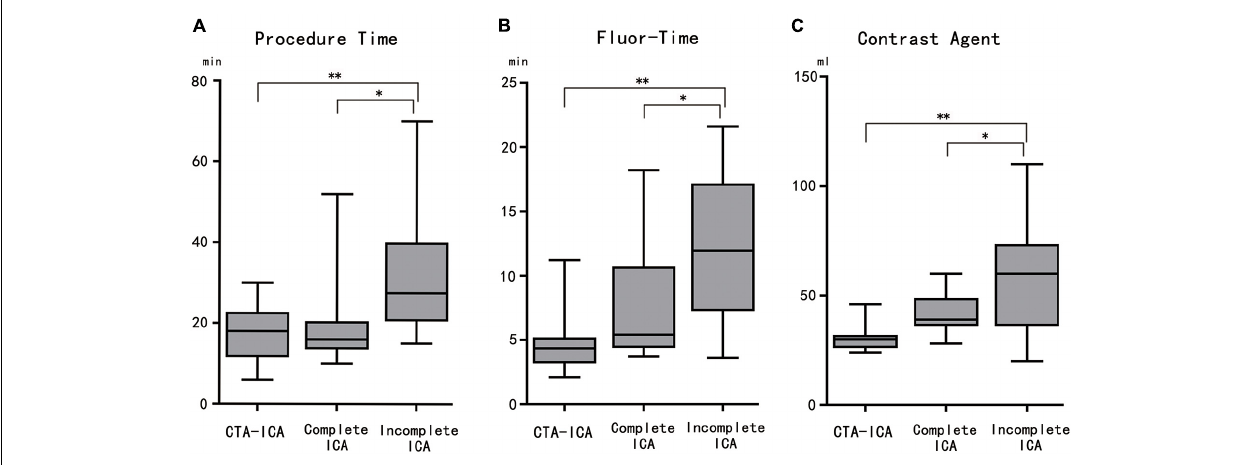
FIGURE 4 | The comparison among CTA–ICA and complete and incomplete direct ICA groups. The procedure time (A) , fluor-time (B) , and contrast agent consumption (C) of the incomplete direct ICA group are significantly increased comparing with the other two groups. CTA, computed tomographic angiography; ICA, invasive coronary angiography; fluor-time, fluoroscopy time; ∗ p < 0.05, ∗∗ p <